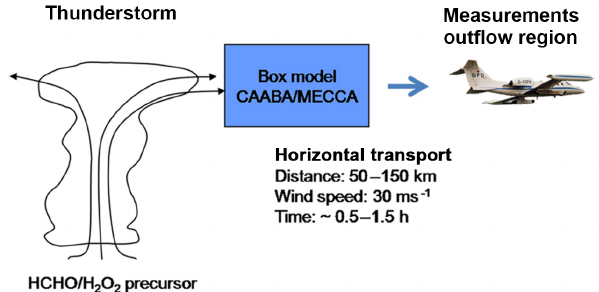
Figure 8. Scheme for the initialisation of the chemical box model studies.